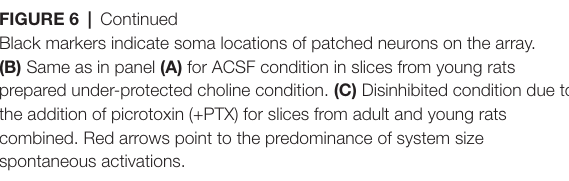
Frontiers in Neural Circuits |